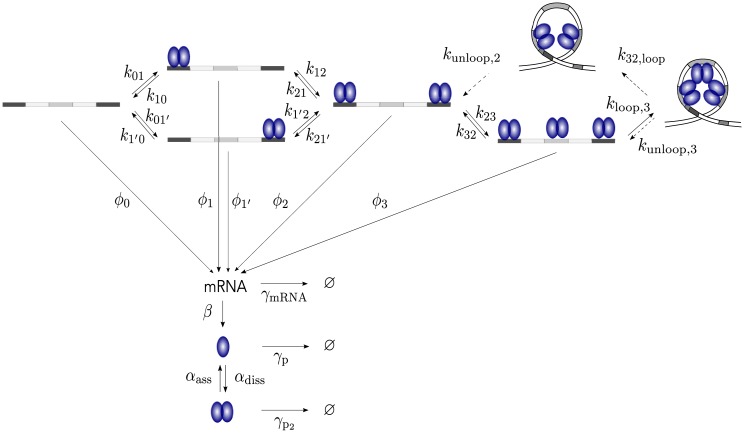
Schematic of the Ss-LrpB system.Ss-LrpB is a dimeric auto-regulative transcription factor. The control region of its own gene contains three binding sites of which the first and third one have a high affinity. Due to cooperativity the middle site will get bound and the DNA subsequently loops on itself. The system of unbinding is unknown and two hypotheses, either through direct unlooping or either by first unbinding the protein of the middle site, are denoted by dashed arrows. All DNA configurations have their own transcription rates, which lead to a non-monotonic response curve. mRNA will be translated to monomers which can dimerize. The model also takes into account degradation/dilution of all proteins (mRNA, monomers and dimers).